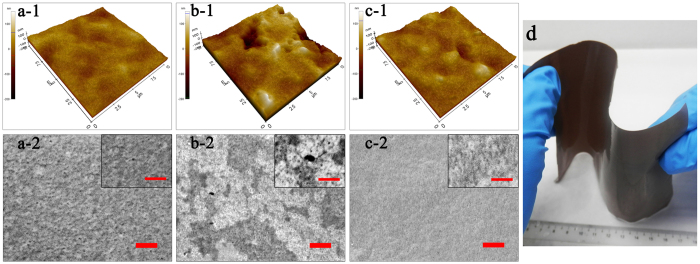
The structure of membrane selective layer.(a) P membrane, (b) GO-P membrane, (c) GO-P-S membrane. (a-1~c-1) AFM images of membrane topography. (a-2~c-2) FESEM images of membrane top surface, scale bar 300 nm; the inserted figures are enlarged FESEM images of membrane top surface, scale bar 150 nm. (d) Optical photo of GO-P-S membrane which demonstrates its outstanding mechanical flexibility.